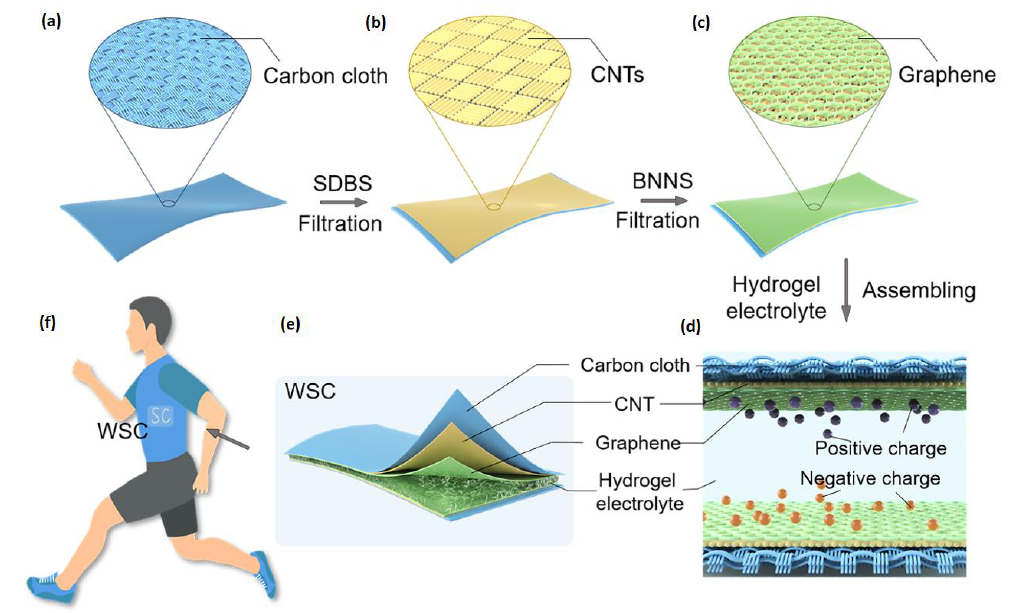
Figure 1. A schematic showing the fabrication process and structure of the wearable supercapacitor (WSC). ( a ) The carbon cloth was used as a current collector. ( b ) The carbon nanotubes (CNTs) were loaded on the carbon cloth through filtration, where sodium dodecylbenzene sulfonate (SDBS) was used as a dispersant. ( c ) The graphene was mounted on the CNTs layer through filtration, where boron nitride nanosheets (BNNS) was used to prevent graphene from collapsing. ( d ) The as-fabricated WSC was assembled with hydrogel used as a solid electrolyte. ( e ) The schematic structure of the WSC. ( f ) The WSCs could be integrated into clothing to power wearable